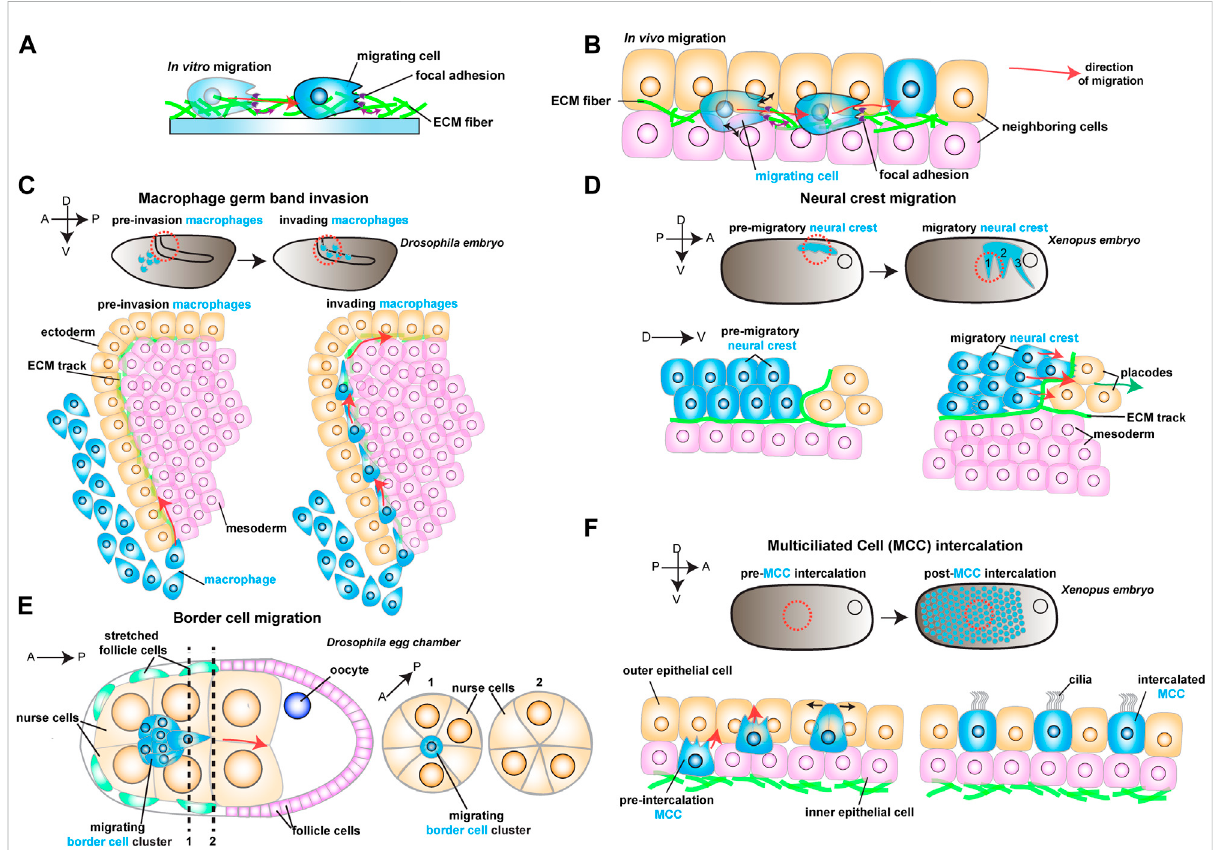
FIGURE 1 Schematic representation of different models to study in vivo cell migration. Red arrows show the direction of migrating cells. (A) Example of a cell (in blue) migrating in vitro on an ECM coated dish. As the cell moves, it reads mechanical cues from the ECM (purple arrows). (B) Example of a migrating cell (in blue) moving in vivo through complex environments composed of different cell types (in orange and pink) and extracellular matrix (ECM, in green). As the cell moves, it reads mechanical cues from the ECM (purple arrows) and the neighboring cells (black arrows). (C) Drosophila macrophage germ band invasion: (Top) Macrophages (in blue) migrate through the developing embryo and invade the germ band. (Bottom) Macrophages (in blue) invade the germ band by crawling through an ECM track laid between the ectoderm (in orange) and the mesoderm (in pink). (D) Xenopus Neural crest migration: (Top) Neural crest (NC) migrates as streams (in blue) along the embryo. (Bottom) NC cells (in blue) undergoepithelialtomesenchymaltransitionandchaseaftertheplacodes(inorange).TheNCcrawlsonanECMtrack(ingreen),whichislaidontop of the mesoderm (in pink) and the placodes (in orange). (E) Drosophila Border cell migration: the border cell cluster (in blue) migrates through the middle of the egg chamber towards the posterior end, squeezing through the neighboring nurse cells (in orange). (F) Xenopus Multiciliated Cell intercalation: (Top) Multiciliated cells migrate to form the embryonic epidermis. (Bottom) Multiciliated cells (MCC) move from the inner epithelial layer (in pink) towards the outer epithelial layer (in orange), where they integrate the tissue by pushing the neighboring cells aside (black